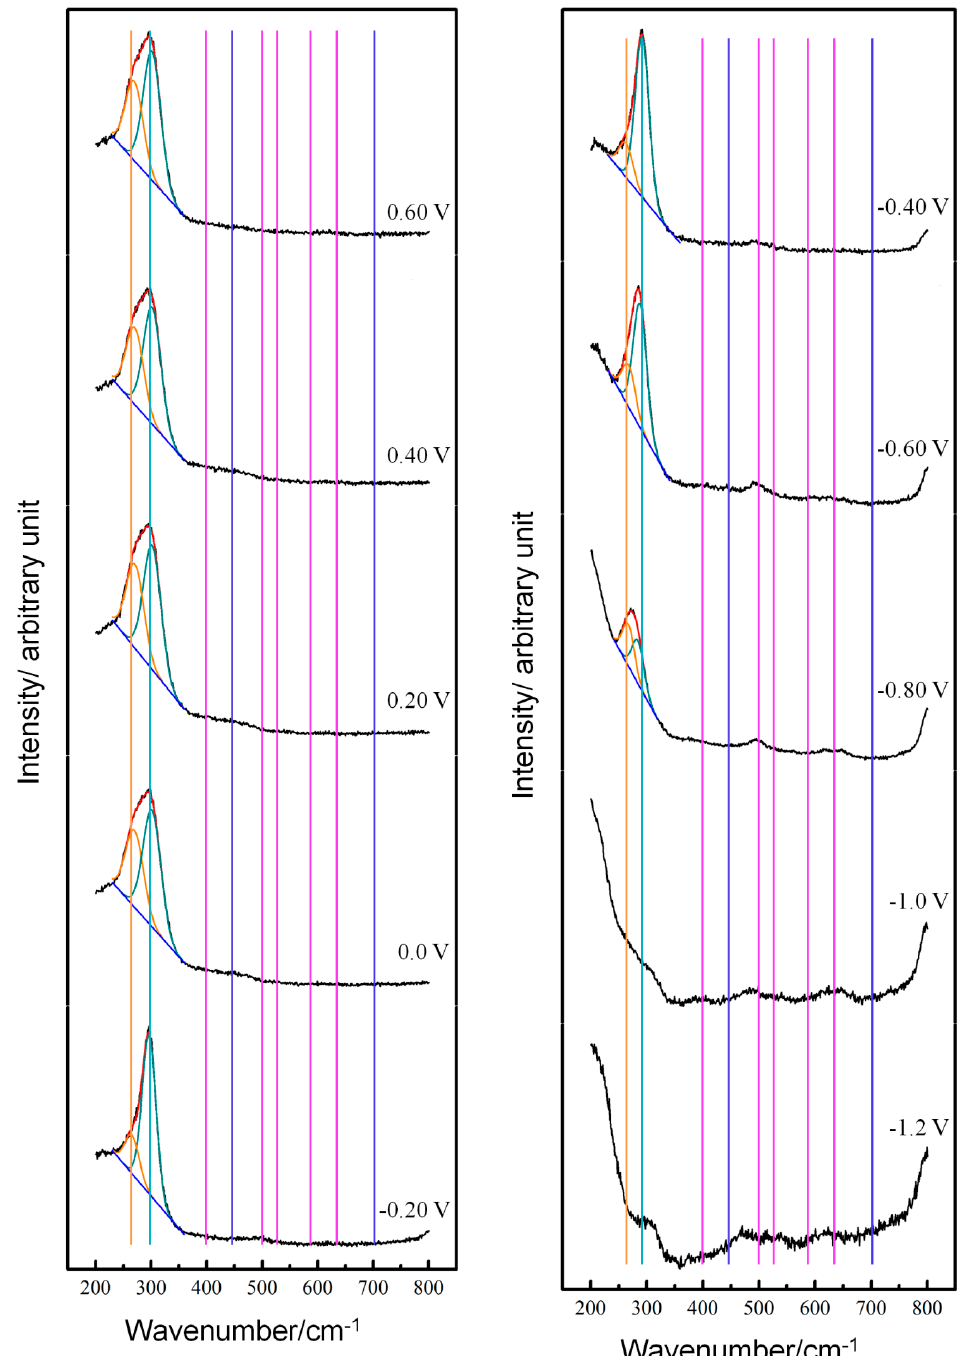
Figure 1. In-situ Raman spectra and fitted Gaussian components from copper electrode surface in neutral 3.5% (wt.) NaCl solution at open circuit potential (OCP) and with applied potential varying from − 1.2 to 0.60 V and then reversing to − 1.2 V.